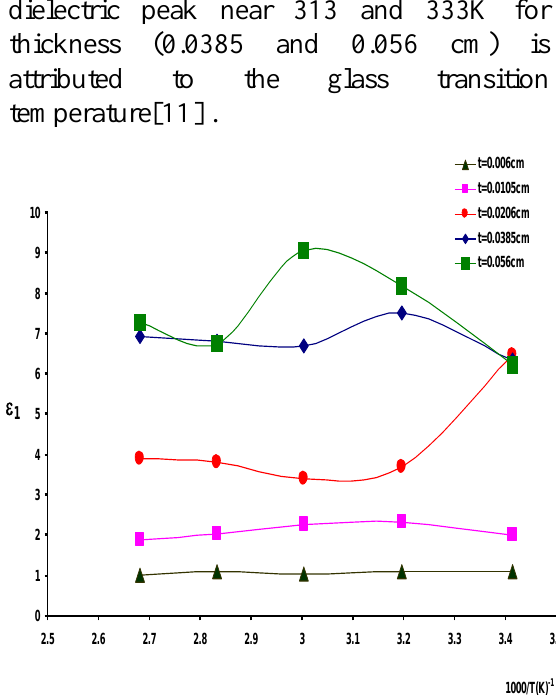
Fig.3: Temperature dependence real part of permittivity (ε ) for PMMA film of different 1 thickness at 10 kHz.